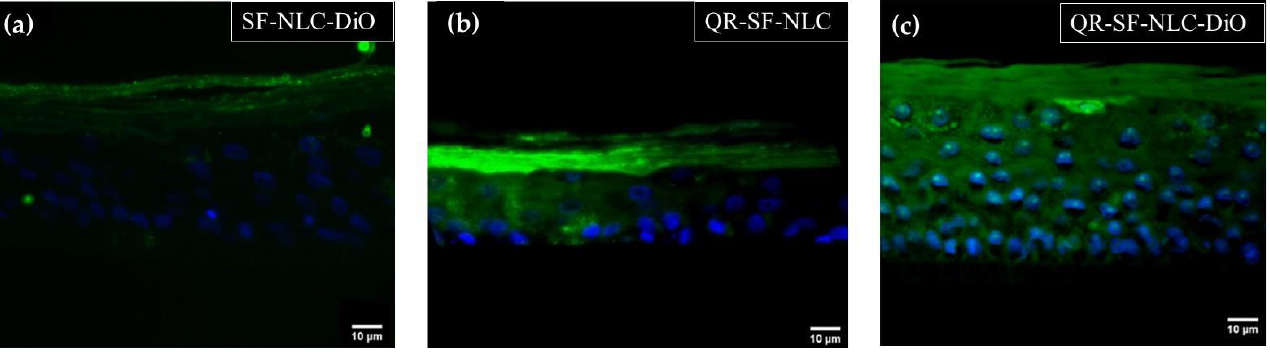
Figure 11. Fluorescence microscopy images of the in vitro skin absorption study after 24 h on RHE: ( a ) SF-NLC-DiO, ( b ) QR-SF-NLC, and ( c ) QR-SF-NLC-DiO. Images show skin cross-sections (5 μm) of RHE cryopreserved in 30% sucrose and stained with hematoxylin-erythrosine: magnification 400 × . Cell nuclei are stained with DAPI (blue) (Ex/Em of 358/461 nm), and green fluorescence corresponds to SF-NLC-Dio with the DiO fluorophore (Ex/Em of 484/501 nm) or QR-SF-NLC (Ex/Em of 450/535